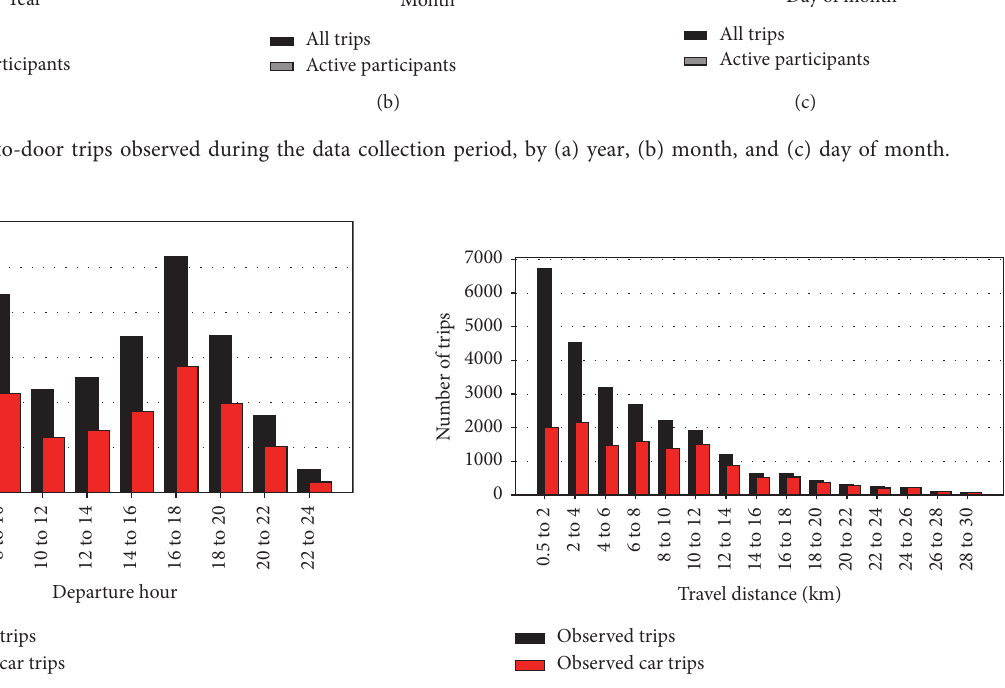
Figure 5: All observed trips vs. observed car trips, grouped by travel